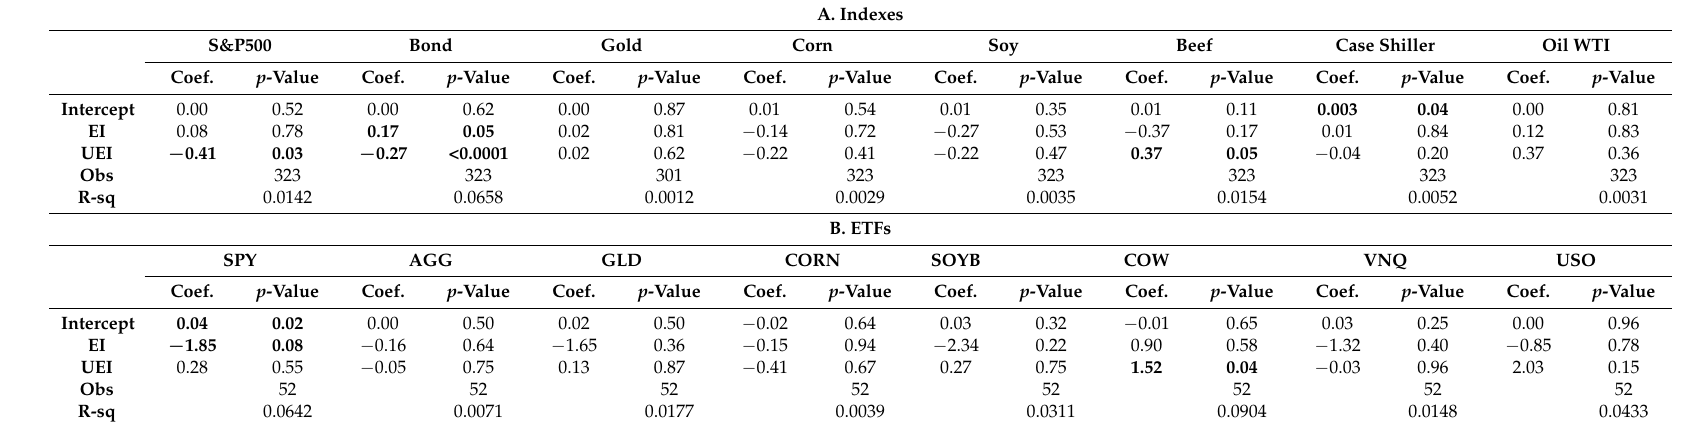
Table 5. Regression results, expected and unexpected inflation.